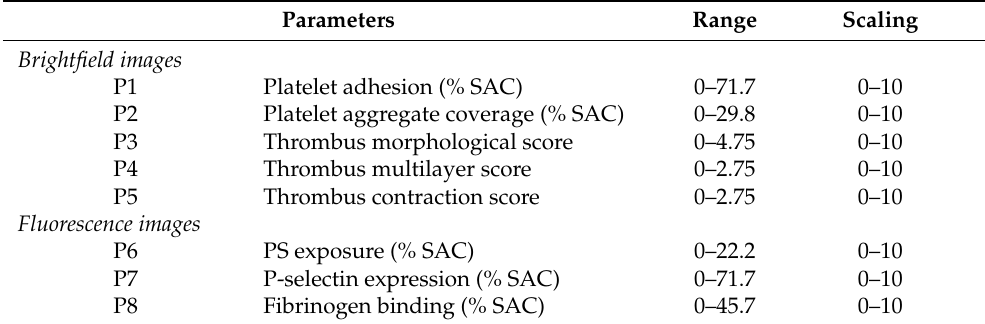
Table 1. Overview of obtained parameters (P1–8) of thrombus formation from brightfield and fluorescence images. Measured ranges and scaling factor for heatmap analysis are also indicated. Abbreviations: PS, phosphatidylserine; SAC, surface area coverage. For details of how the parameters were established using scripts in Fiji, see Supplementary Materials.